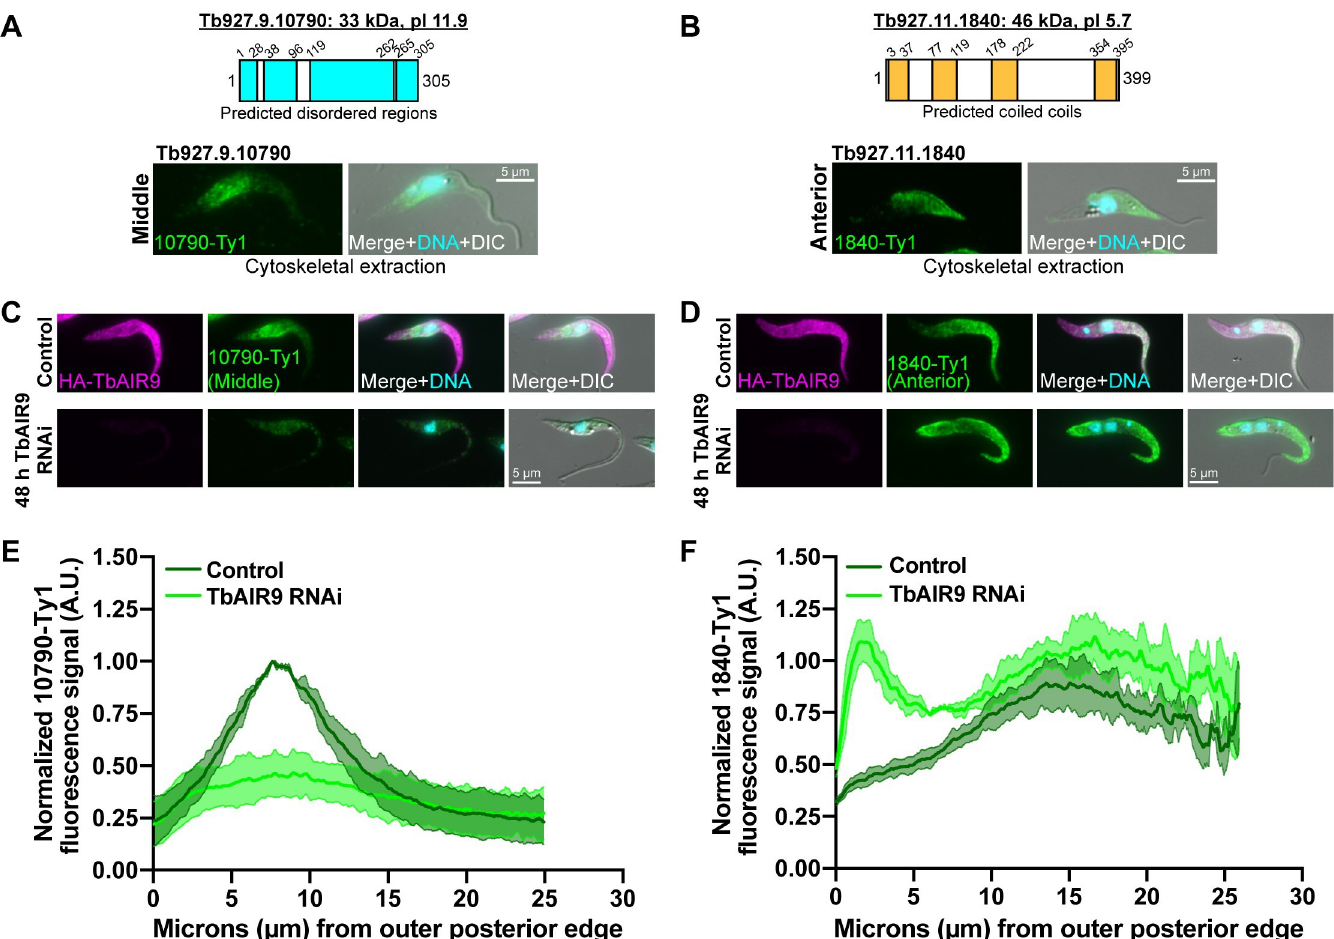
Fig 8. TbAIR9 maintains the localization array-associated proteins at specific subdomains. (A, B) Identification of array-associated proteins from TrypTag that localize to the middle subdomain (A, Tb927.9.10790) and the anterior subdomain (B, Tb927.11.1840). The schematics illustrate the predicted molecular weight (kDa) and pI for each protein. Tb927.9.10790 does not share homology with any known proteins, but it is predicted to be highly unstructured. Tb927.11.1840 also does not share homology with any known proteins, but it contains predicted coiled coils. Tb927.9.10790 and Tb927.11.1840 were tagged at their C-termini with Ty1 and a cytoskeletal extraction followed by immunofluorescence with anti-Ty1 antibody was performed. Tb927.9.10790 and Tb927.11.1840 remained bound to the middle and anterior subdomains of the following cytoskeletal extractions. (C,D) Cell lines containing 10790-Ty1 (C) and 1840-Ty1 (D) endogenous tags were fixed in paraformaldehyde and stained after 2 d of TbAIR9 depletion. 10790-Ty1 signal is depleted and spread throughout the cell body in the absence of TbAIR9, while 1840-Ty1 signal is detected at the posterior and anterior ends in TbAIR9 depleted cells. (E,F) Quantification of 10790-Ty1 (E) and 1840-Ty1 (F) fluorescent signal intensity along the ventral side of the cell body in TbAIR9 RNAi cells after 2 d of TbAIR9 depletion. The signal intensities were normalized to the maximum control values and plotted with the S.D. 50 1N1K cells in both control and TbAIR9 RNAi conditions from N = 3 independent biological replicates were measured. In our analysis of potential array-associated proteins in the TrypTag database, the array posterior (represented here by PAVE1/2), middle (Tb927.9.10790), and anterior (Tb927.11.1840) were the most common localization patterns observed, suggesting that these regions are the primary subdomains of the array (Fig 9A) [63]. Many proteins also localize to the entirety of the array, such as TbAIR9. These primary subdomains each occur at unique places with respect to the flagellum and its attachment in T . brucei . The posterior subdomain comprises an area of the array that is not involved in flagellar attachment, as the flagellum exits onto the cell surface ~4–5 μ m from the posterior edge of the array. The middle subdomain covers the widest point of the cell body, directly after the flagellum exits the flagellar pocket and is attached to the cell surface. This includes the area where the flagellar pocket, kinetoplast,